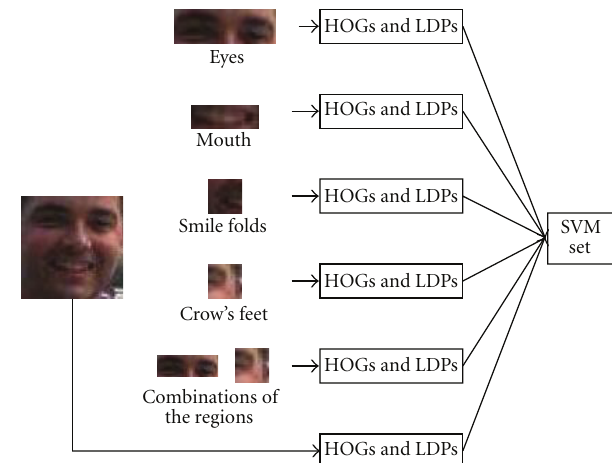
Figure 3: Concept of multilayered histogram of oriented gradients and multilayered local directional patterns (the facial image is extracted from the MPLab GENKI